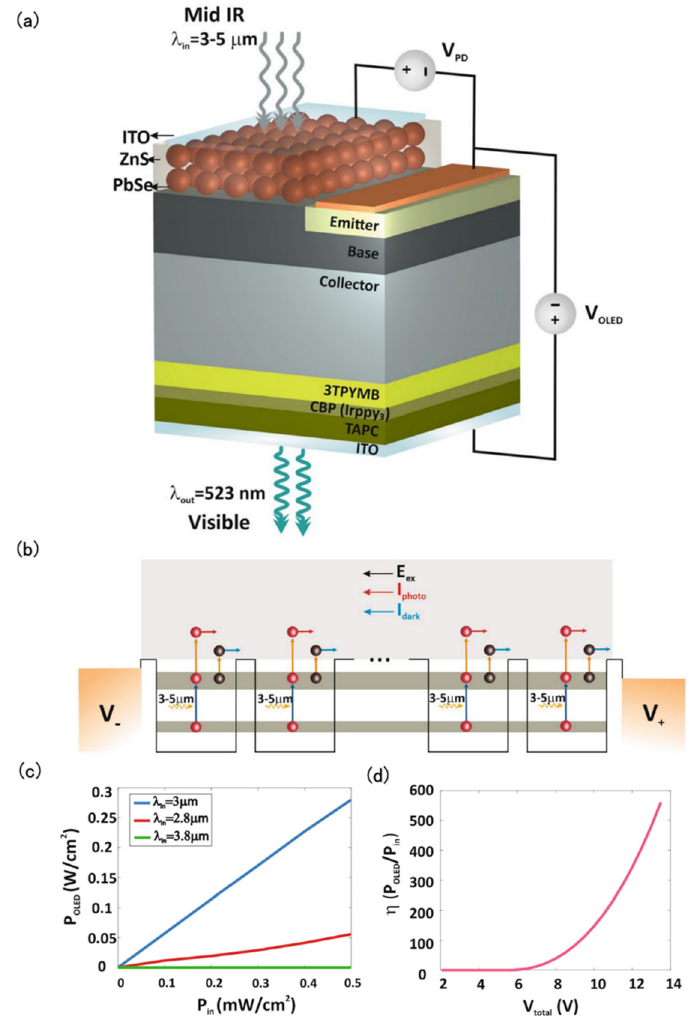
Figure 9. Structures and performance characterization of CQDs-based MIR-to-visible upconversion devices. ( a ) Structure of MIR-to-visible light upconversion device. ( b ) Schematic shows the energy band diagram of the PbSe/ ZnS quantum dots PD and the transition inside PD. The transfer of electrons from the energy levels of the excited state to the continuum by means of the thermal energy of the environment causes a dark current (black circle, I dark ). The photons excite electrons from energy levels of ground state to energy levels of excited state, resulting in a photocurrent (red circle, I photo ). ( c ) The output power density depending on the lighting power density MIR with different wavelengths. ( d ) The efficiency of PbSe upconversion device as function of the applied voltage under MIR light illumination ( λ = 3 μ m, 0.5 mW/cm 2 ) [62]. Copyright 2020, Scientific Re- ports.